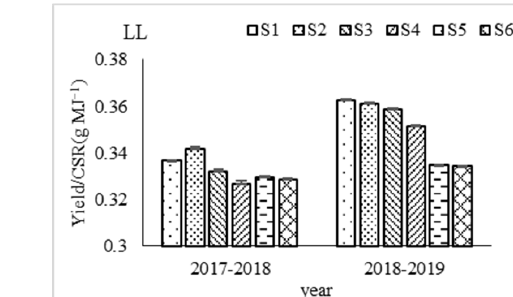
Figure 4. The ratio of yield to cumulative solar radiation at two latitudes in 2017–2018 and 2018–2019. S1, S2, S3, S4, S5 and S6 represent the sowing dates of31 October, 10 November, 20 November, 30 November, 10 December and 20 December, respectively. HL: Donghai County test site, LL: Jianhu County test site. The vertical strip represents the standard error of the average value of the two varieties (nasty 2).